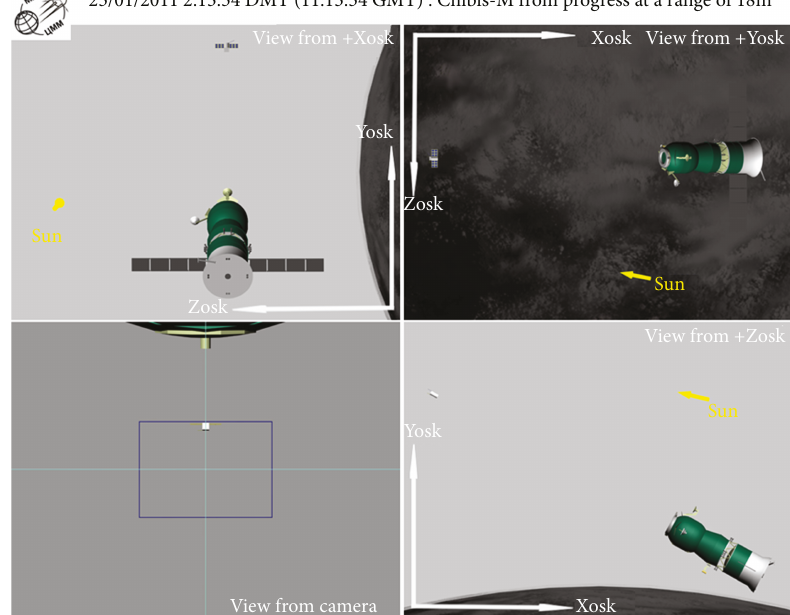
Figure 9: “ Progress-13M ” position relative to the Sun and the orbital frame during the undocking of the “ Chibis-M. ”